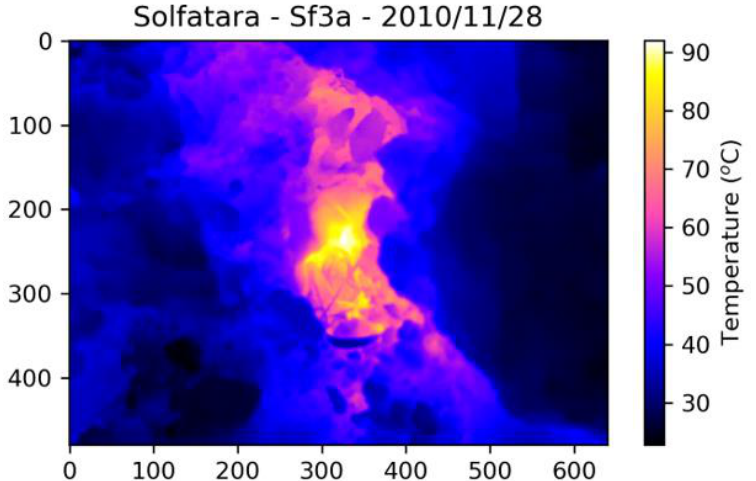
Figure 9. Example of thermal image of the station Ps1a at the Pisciarelli area (Campi Flegrei), indi- cated as “Ps1a” in Fi gure 1.